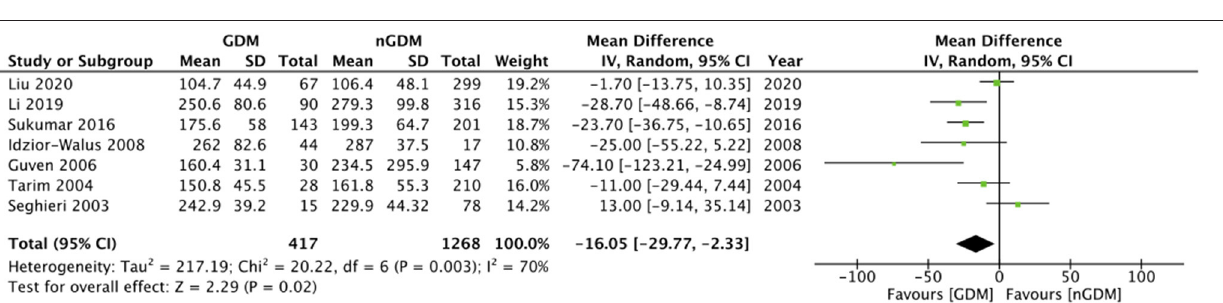
FIGURE 3 | Meta-analysis of serum vitamin B12 concentration during pregnancy between GDM and non-GDM